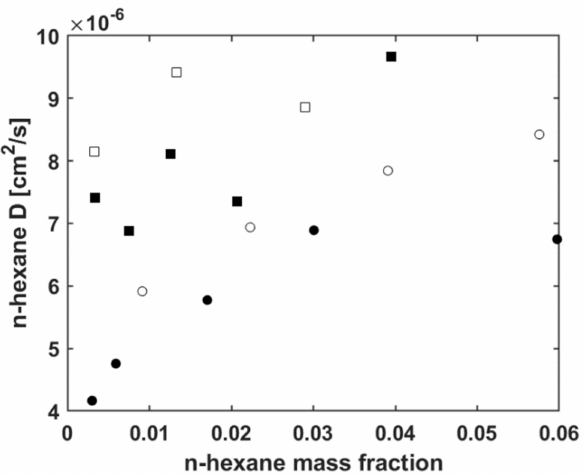
Figure 4. Values of n-hexane-V8880 mutual diffusivity as a function of n-hexane mass fraction in the polymer-penetrant mixture at the four investigated temperatures (115 ◦ C (black circles), 122 ◦ C (white circles), 130 ◦ C (black squares), and 140 ◦ C (white